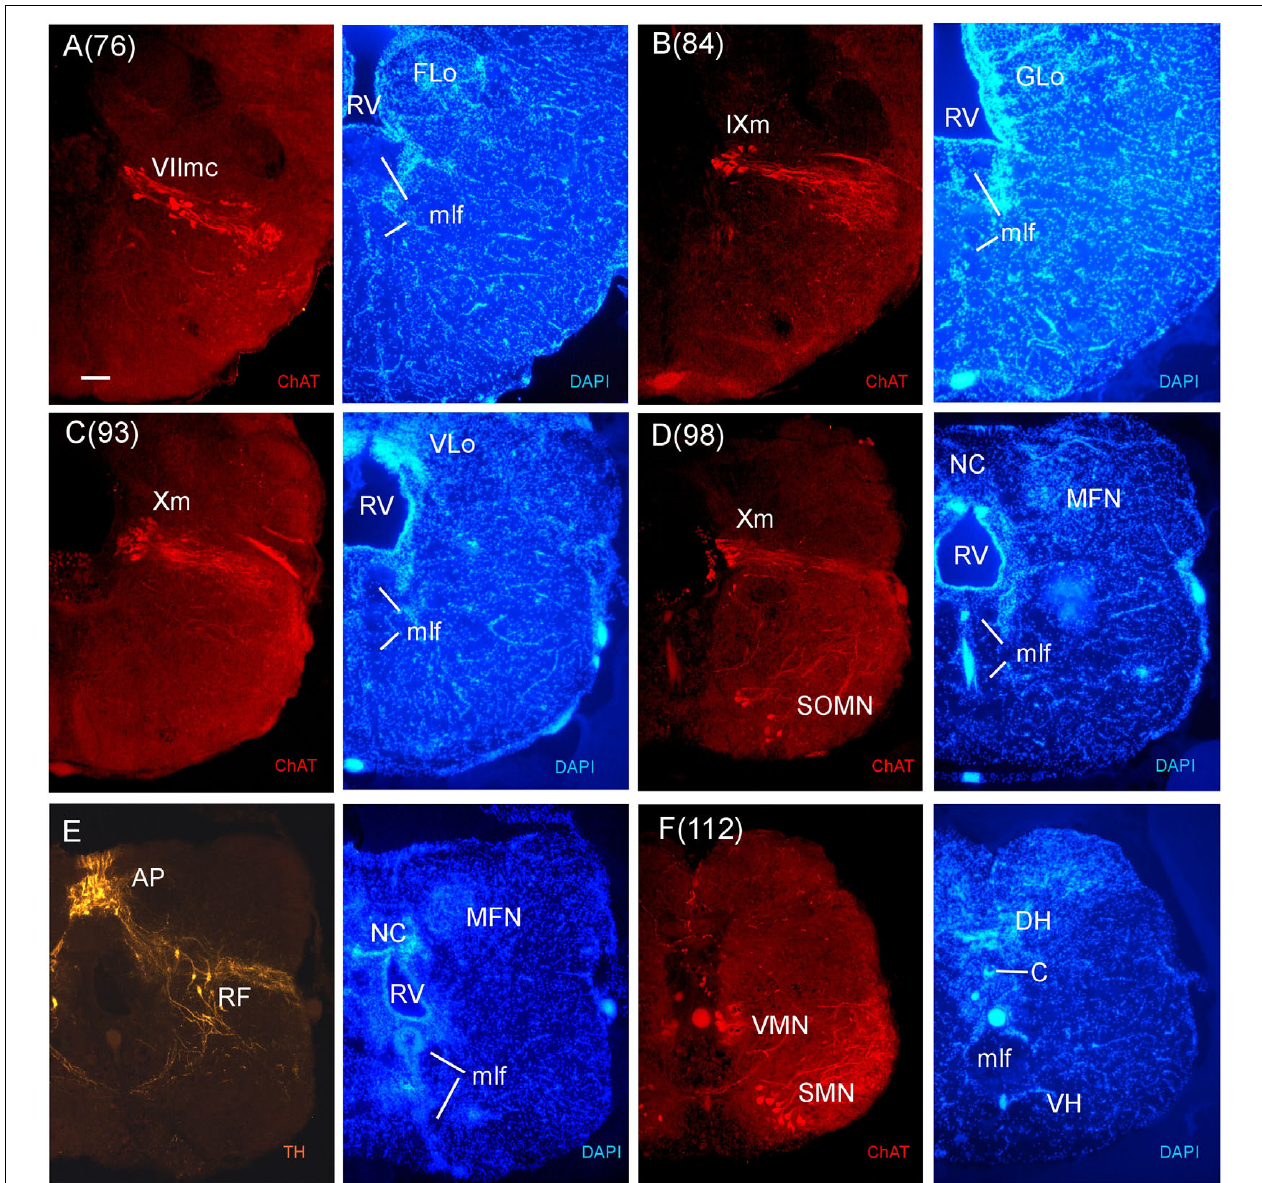
FIGURE 9 | Consecutive transverse sections of the archerfish posterior rhombencephalon double-immunostained for tyrosine hydroxylase (TH) and choline acetyltransferase (ChAT) with accompanying nuclear (DAPI) counterstain. At these caudal rhombencephalic levels, the caudal facial (VIImc, seen in A ), glossopharyngeal (IXm, seen in B ), and vagal (Xm, seen in C and D ) motor nerve nuclei are present, followed by the viscero- and somatomotor spinal cord neurons (SMN, seen in F ). Between rhombencephalon and spinal cord there are some spino-occipital motorneurons (SOMN, seen in D ). Note also the TH positive neurons of the area postrema (AP) and the reticular formation (E) . Arabic numerals in brackets indicate the relative distance of sections. Scale bar in (A) : 0.1 mm (applies to all panels). See abbreviation list and text for details.